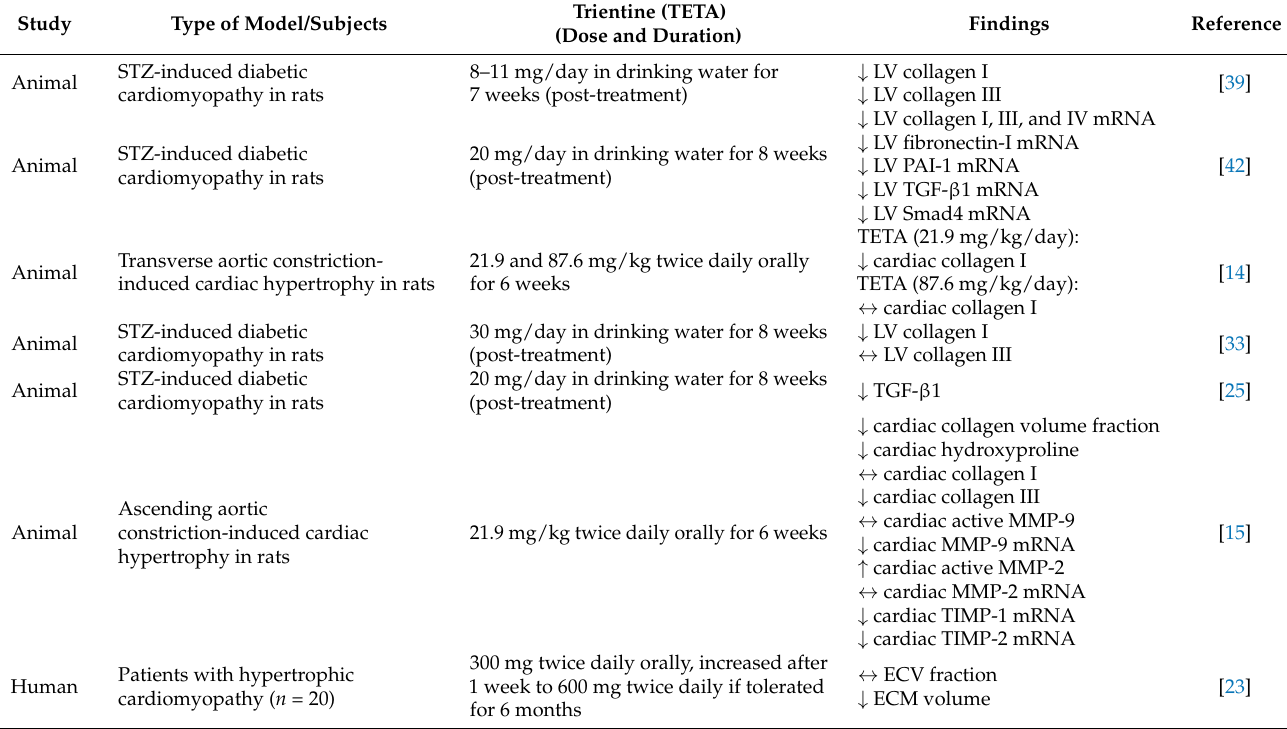
Table 5. Effects of trientine on myocardial interstitial fibrosis and extracellular matrix in human and animal